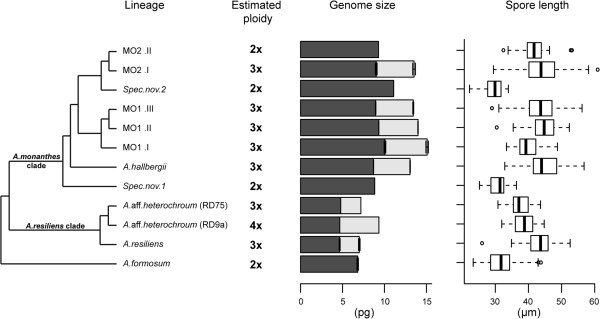
A summarized phylogenetic tree of the Asplenium monanthes complex and related lineages [as presented in 29] together with the inferred ploidy levels (based on published chromosome data), mean holoploid genome size (1C-value; grey bars), and inferred monoploid genome size (1Cx-value; black bars) and the mean spore length (μm) of each operational unit. Posterior branch support >0.8 is shown. For diploids only black bars are present as the 1C-value is equal to the 1Cx-value. Standard error bars are included for 1C-value and 1Cx-value means, except for lineages represented by one specimen only. Tree is rooted according to Dyer et al. [29]. Details of the box plots for spore size are given in the legend to Figure 1.